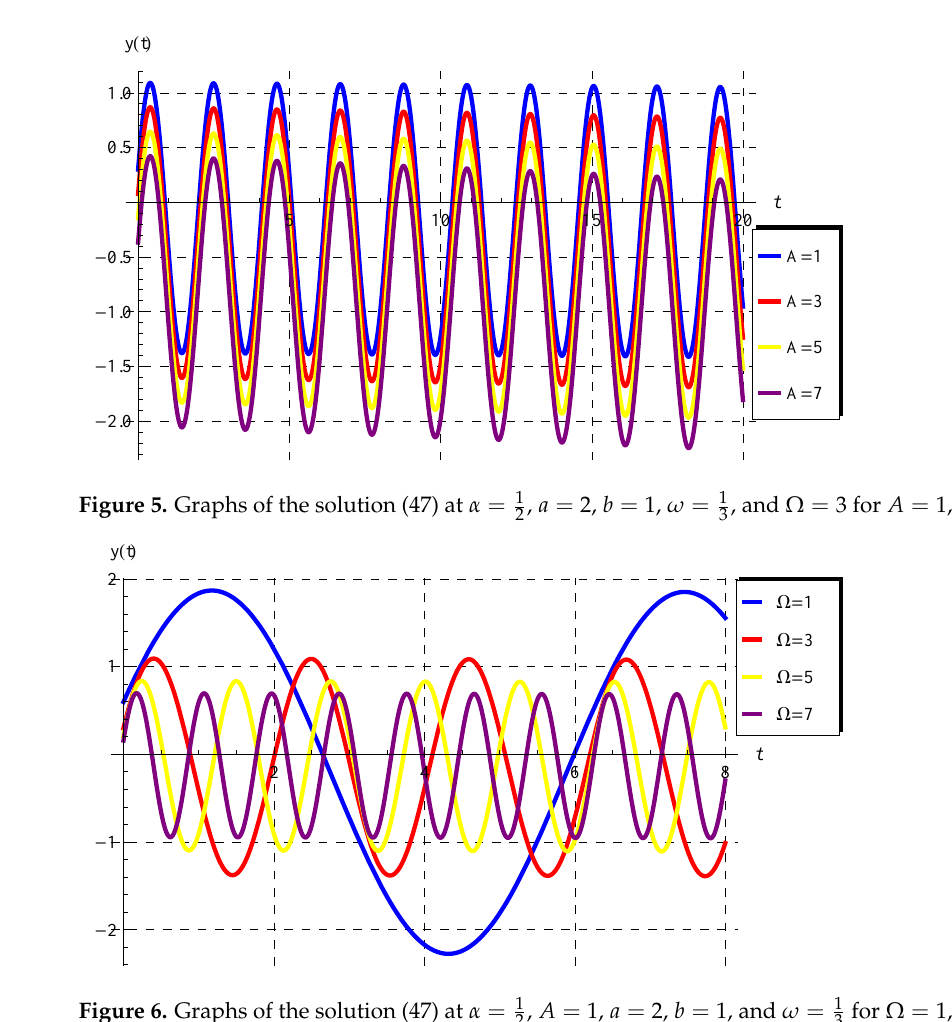
, A = 1, a = 2, b = 1, and ω = 1 2